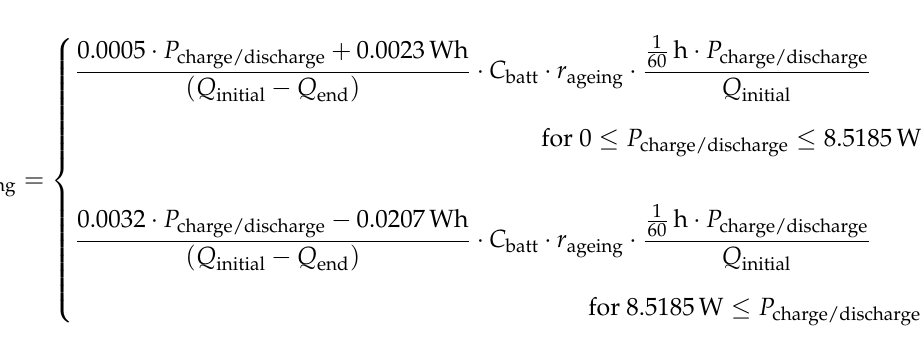
Figure 1. Battery energy fade in